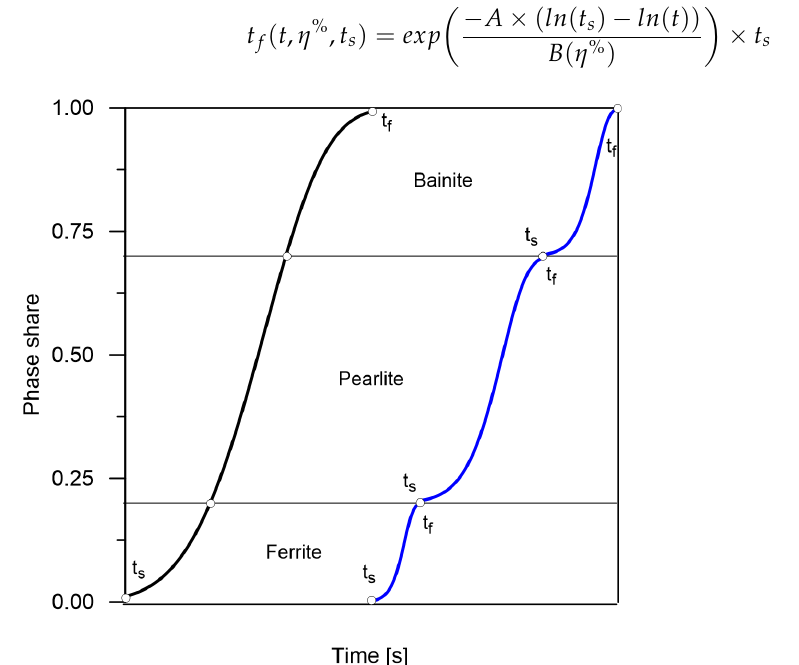
Figure 3. Difference in kinetics of phase transformations—a model of joint and separated